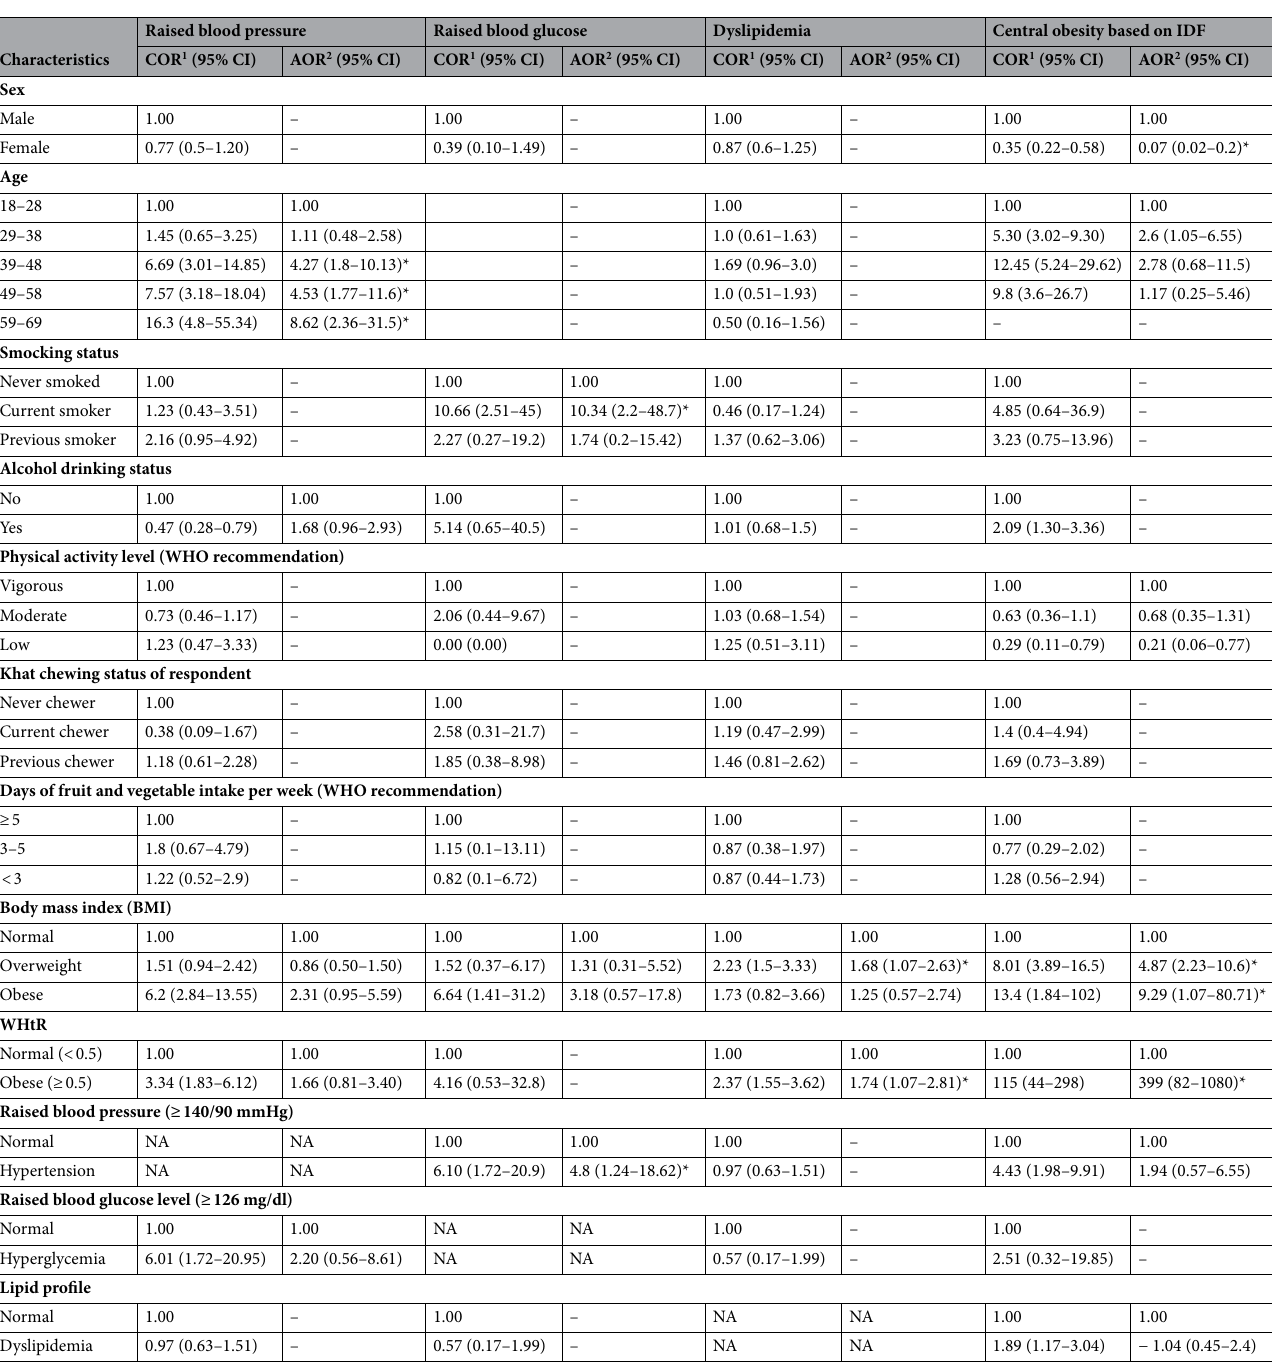
Table 5. Bivariate and multivariate analyses of demographic and clinical risk factors for raised blood pressure, raised blood sugar, dyslipidemia and central obesity of study subjects. EPHI, Ethiopia, Addis Ababa, 2018 (n = 450). Raised blood pressure (systolic BP ≥ 130 mmHg, diastolic BP ≥ 85 mmHg) DM: diabetes mellitus (raised fasting glucose ≥ 100 mg/dl), central obesity (defined by a waist circumference ≥ 94 cm for men and ≥ 80 cm for women), Dyslipidemia (defined by raised triglyceride level ≥ 150 mg/dl and reduced HDL < 40 mg/dl in men and < 50 mg/dl in women).WHtR (waist to height ratio, COR (crude odds ratio), AOR (adjusted odds ratio). *Significant during multi logistic